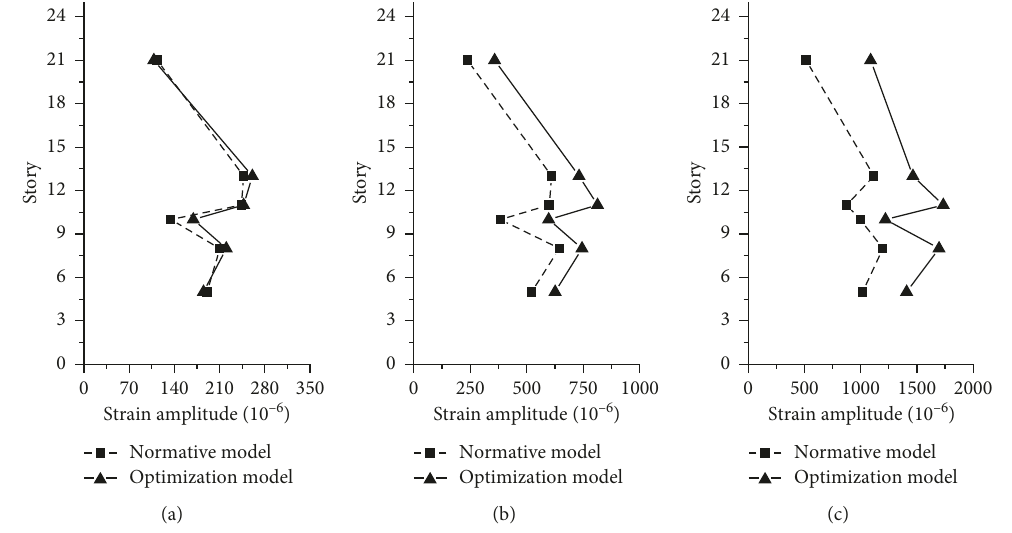
Figure 7: Maximum strain value of frame beam at different story. (a) Frequent intensity 7, (b) basic intensity 7, and (c) rare intensity